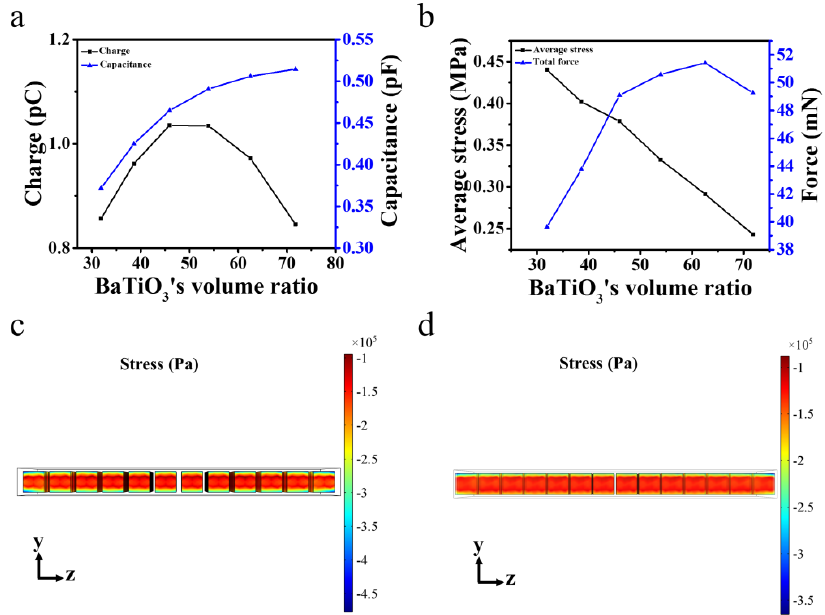
Figure 3. ( a ) The PENG’s top surface charge and capacitance with different BaTiO 3 ratios. ( b ) The averaged stress and total force on the top surface of the embedded BaTiO 3 cubes. The distribution of stress in the BaTiO 3 at 45.9% ( c ) and 62.5% ( d ).